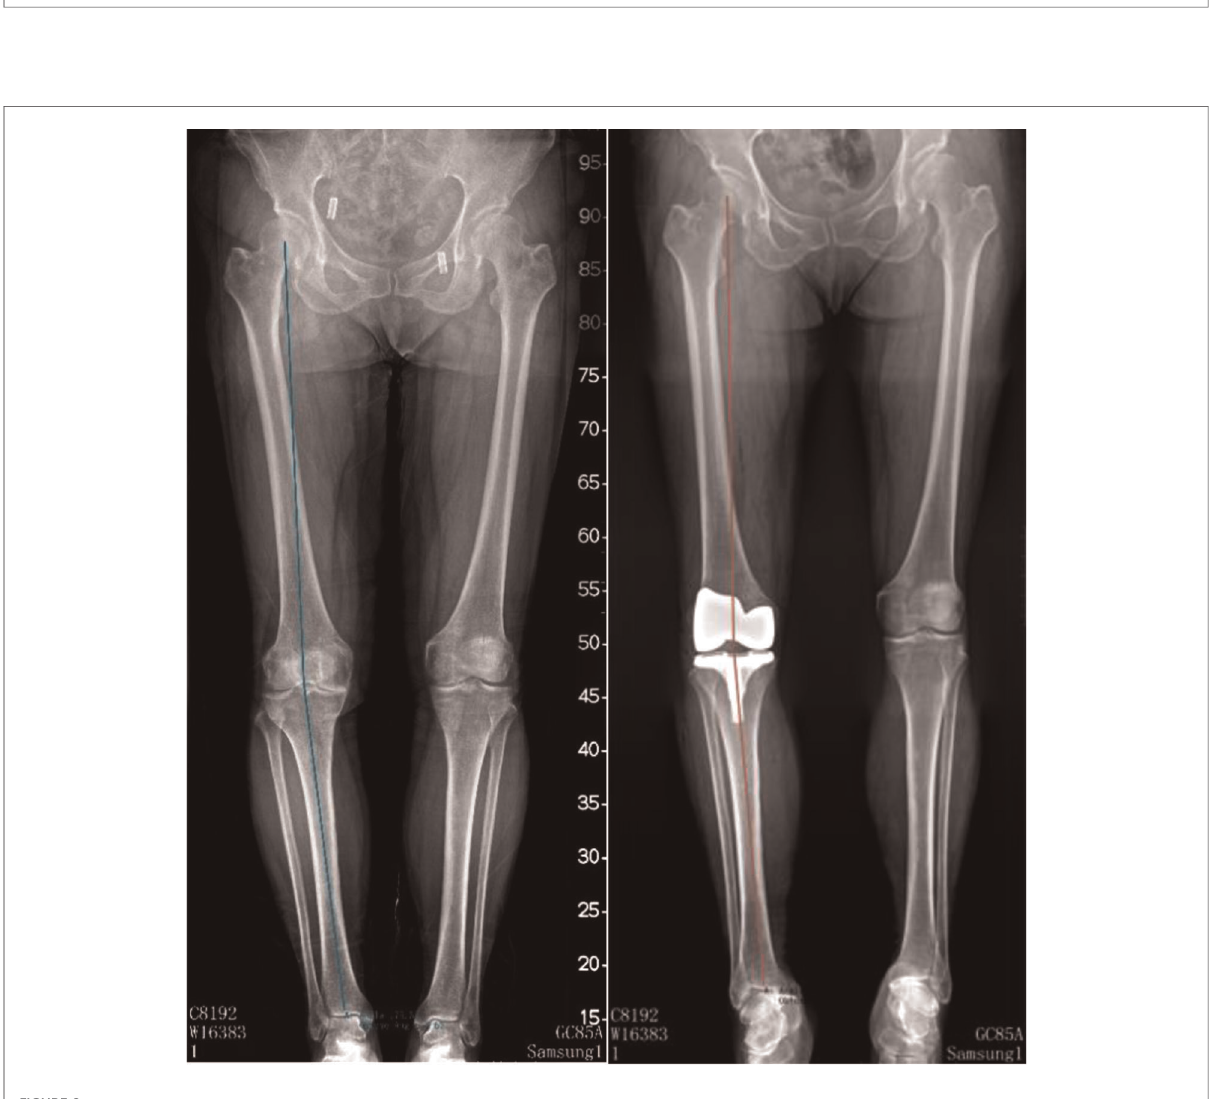
FIGURE 2 Pre-operation and post-operation HKAA measurement